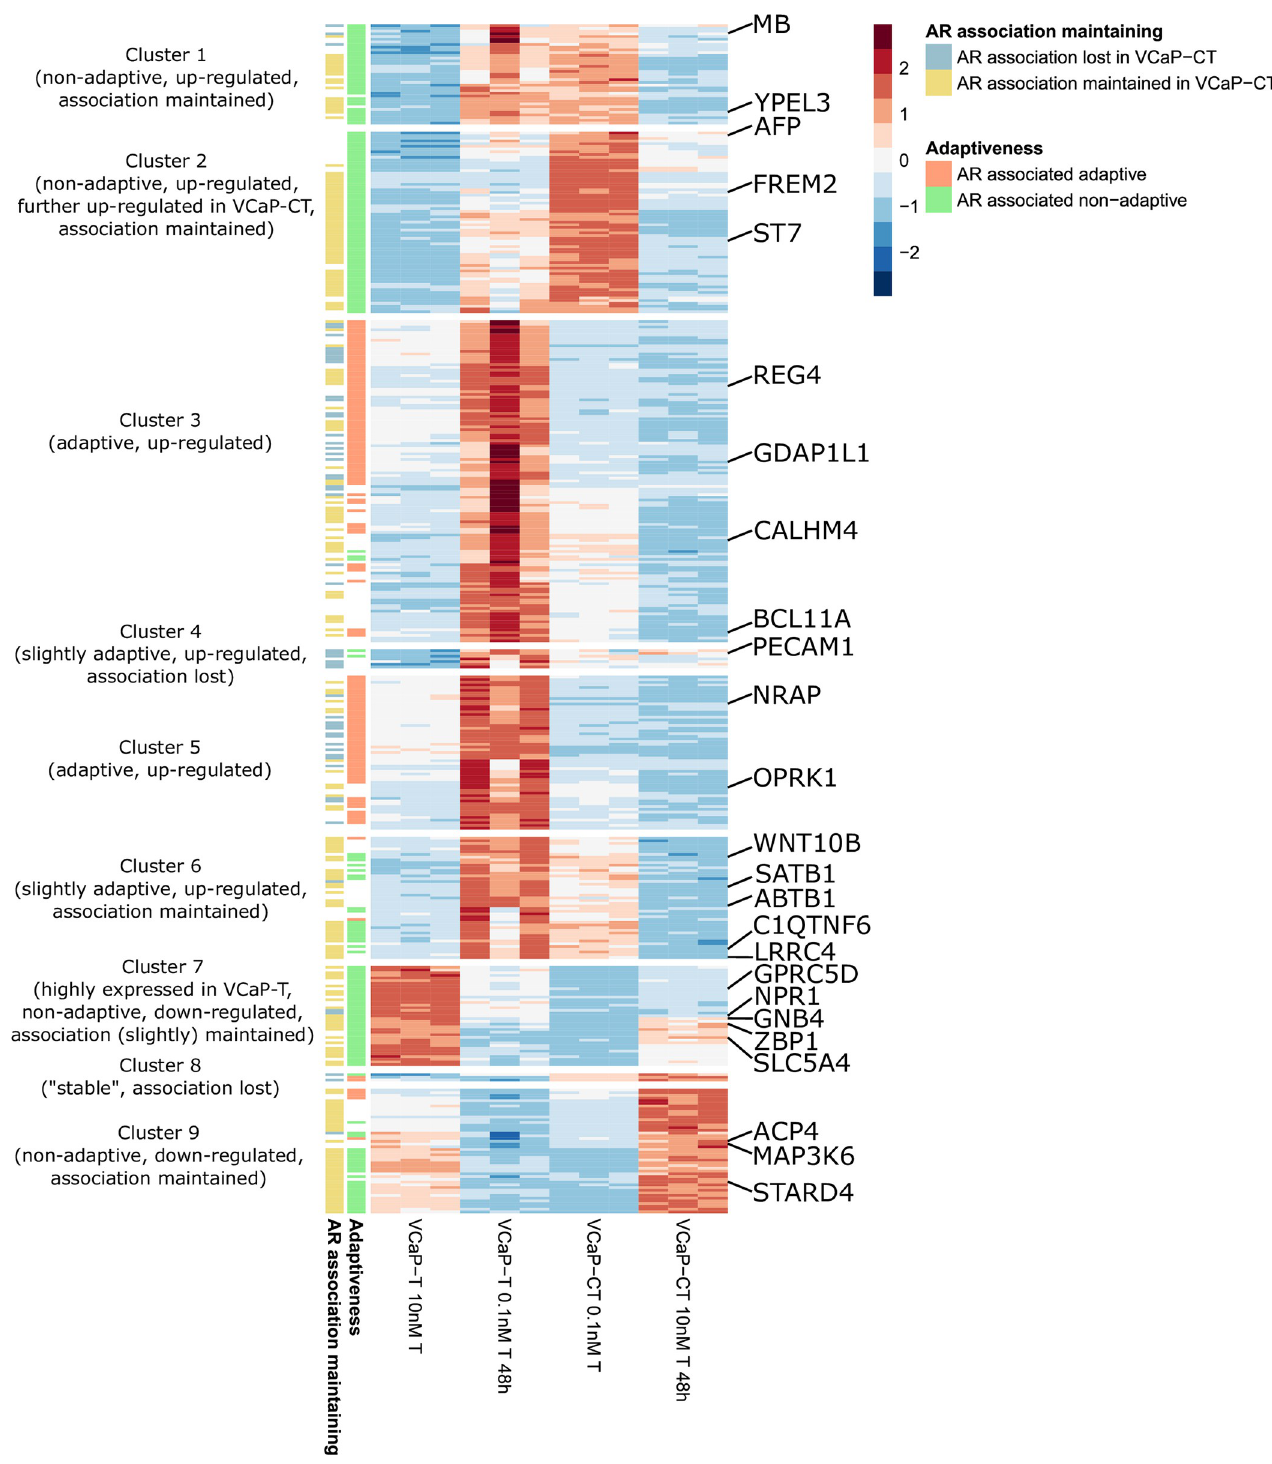
Fig 5. AR-associated genes. Heatmap illustration of expression levels of 418 AR-associated genes in VCaP-T and VCaP-CT cell lines upon testosterone level changes. Expression levels are scaled and centered by row. Using hierarchal clustering with Euclidean distances genes were clustered into 9 clusters with different characteristics. Genes with association to progression-free survival are